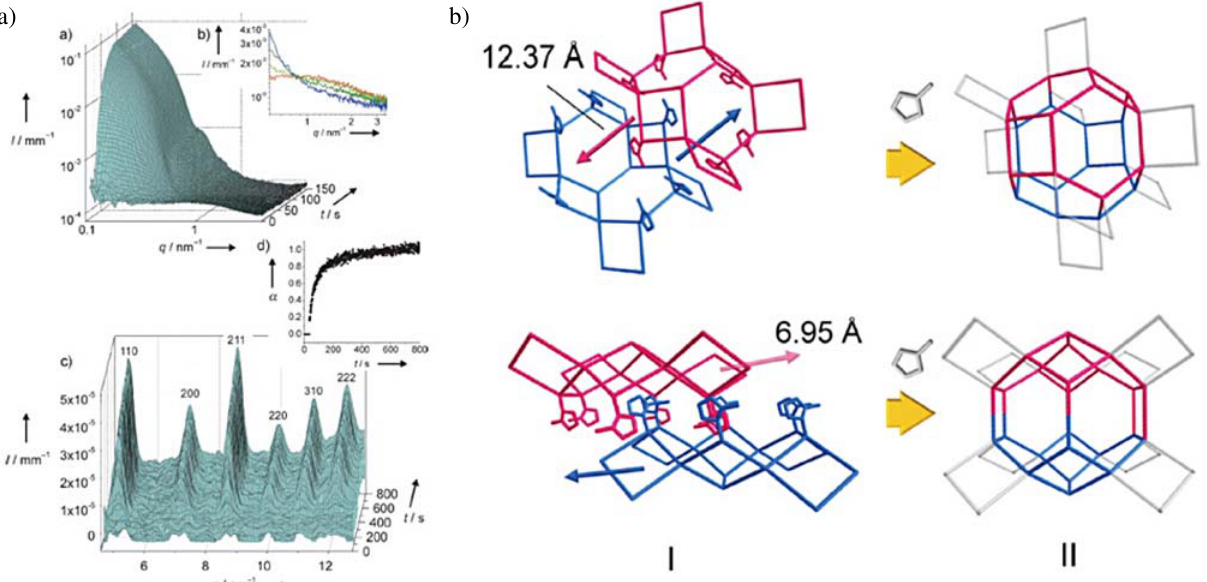
Figure 1. (a) Time-resolved scattering patterns during ZIF-8 nanocrystal formation. Above: SAXS patterns for the first 150 s with the acquisition time interval of 1 s. Inset shows high-q region of selected SAXS patterns originating from the small clusters. Below: WAXS patterns measured bet- ween 1 and 800 s with the acquisition time interval of 1 s. Inset shows plot of the extent of crystallization a versus time t as produced from the in- tegrated intensity of the 211 reflections in the WAXS patterns. 35 (b) Proposed scheme of ZIF-8 formation mechanism from layered phase shown along [ 100 ] direction (upper scheme) and [ 010 ] direction (lower scheme). 36 Reprinted with permission. Copyright American Chemical